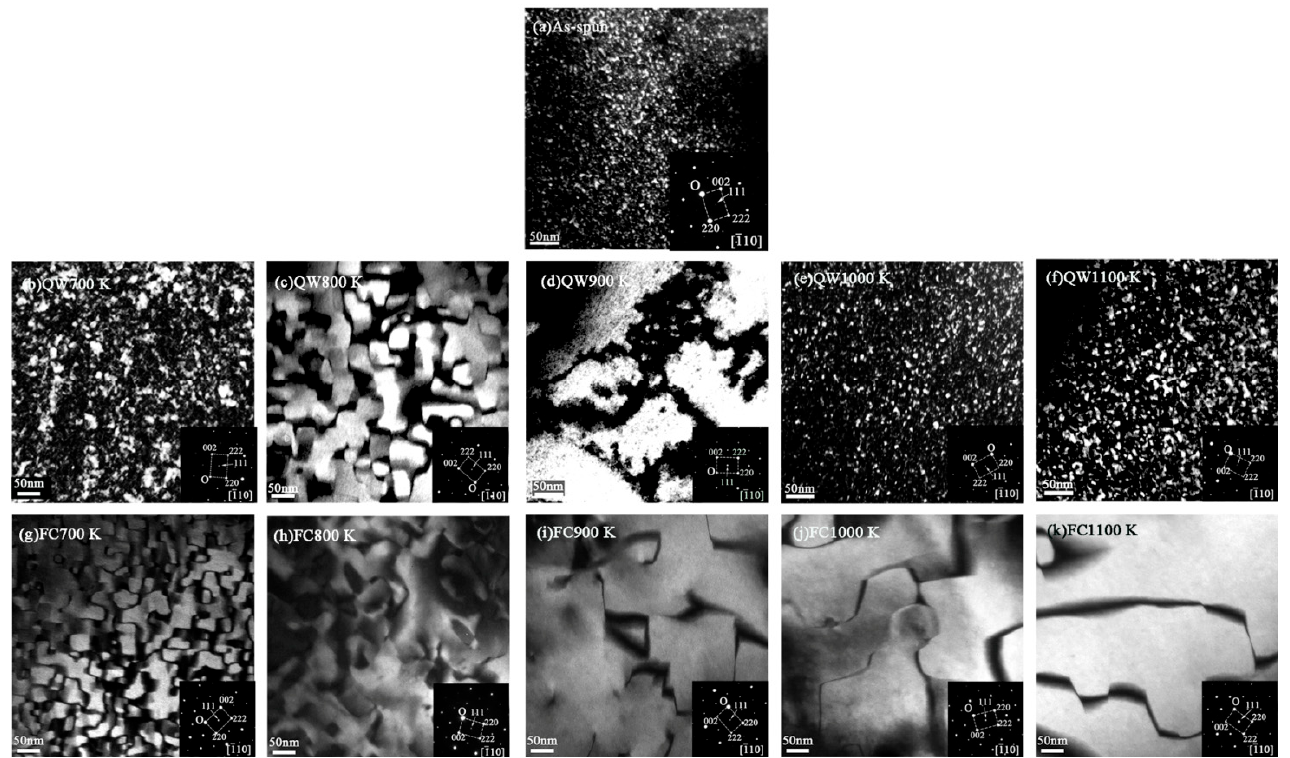
Figure 2. The dark-field images using (111) reflection taken from Ni 45 Co 5 Mn 36.6 In 13.4 ribbons for ( a ) as-spun, quenched at ( b ) 700 K, ( c ) 800 K, ( d ) 900 K, ( e ) 1000 K and ( f ) 1100 K; and annealed at ( g ) 700 K, ( h ) 800 K, ( i ) 900 K, ( j ) 1000 K and ( k ) 1100 K, respectively. Inset of each of image is the corresponding SAD patterns along (110) zone axis of the bright domains in the dark field image.